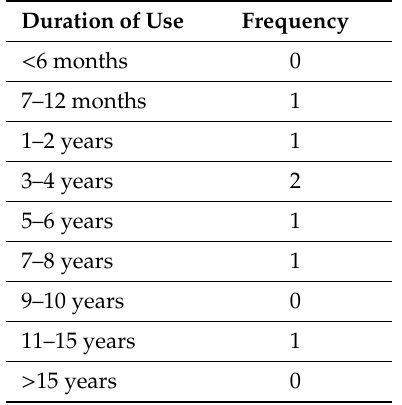
Table 26. Duration of use before abandonment (N =